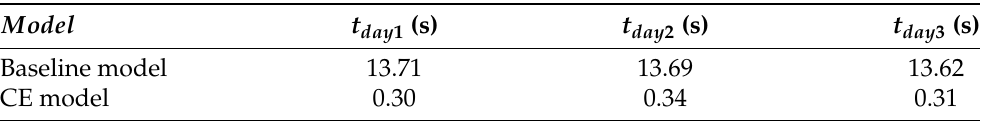
Table 5. Comparison of computation time taken by the optimisation problem using the CE model and the baseline